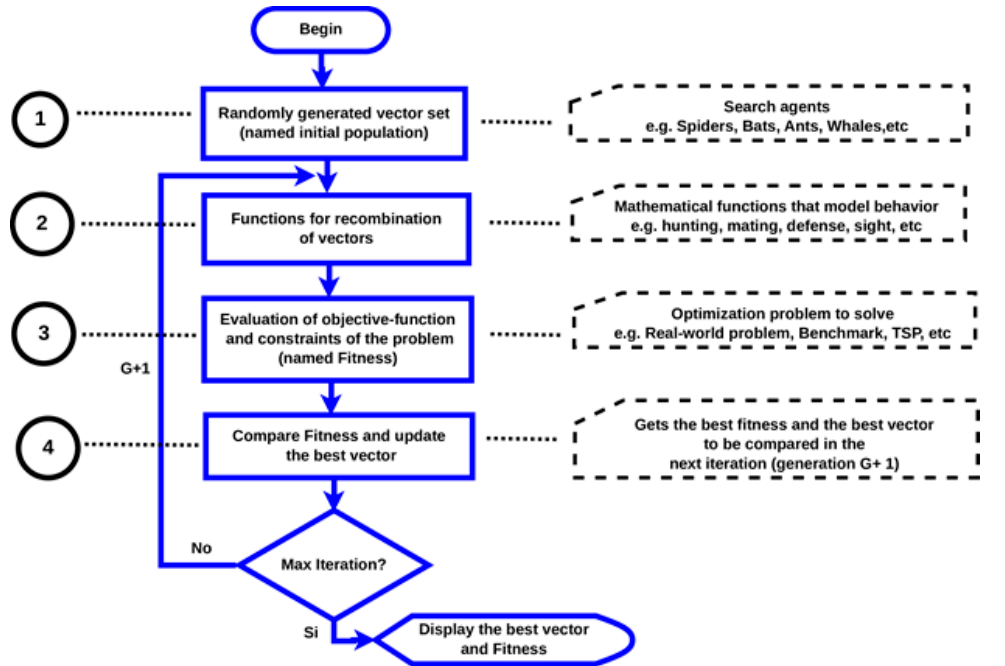
Figure 1. General structure of a bio-inspired algorithm.